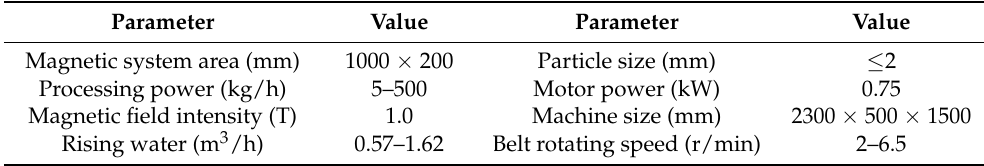
Table 2. Main parameters of plate high gradient magnetic separator.